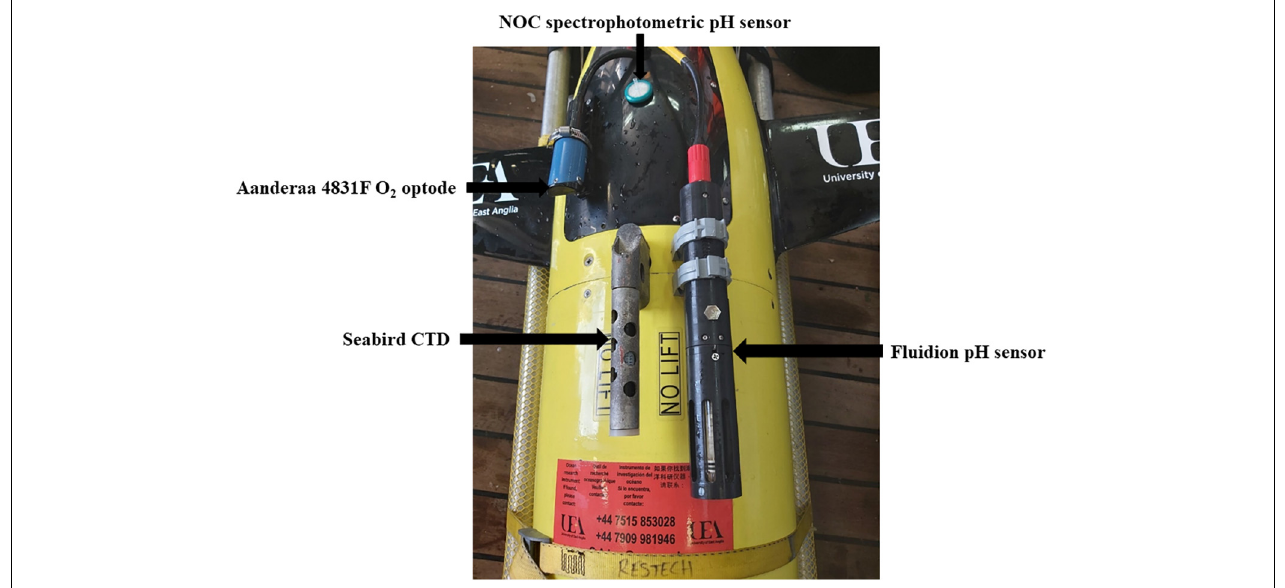
FIGURE 2 | UEA Seaglider 510 “Orca” before the deployment showing the Aanderaa 4831F oxygen optode (Tengberg et al., 2006), a Sea-Bird CT sail (conductivity and temperature), the Fluidion potentiometric pH sensor, and the inlet filter of the NOC lab-on-chip (LoC) spectrophotometric pH sensor (Rérolle,